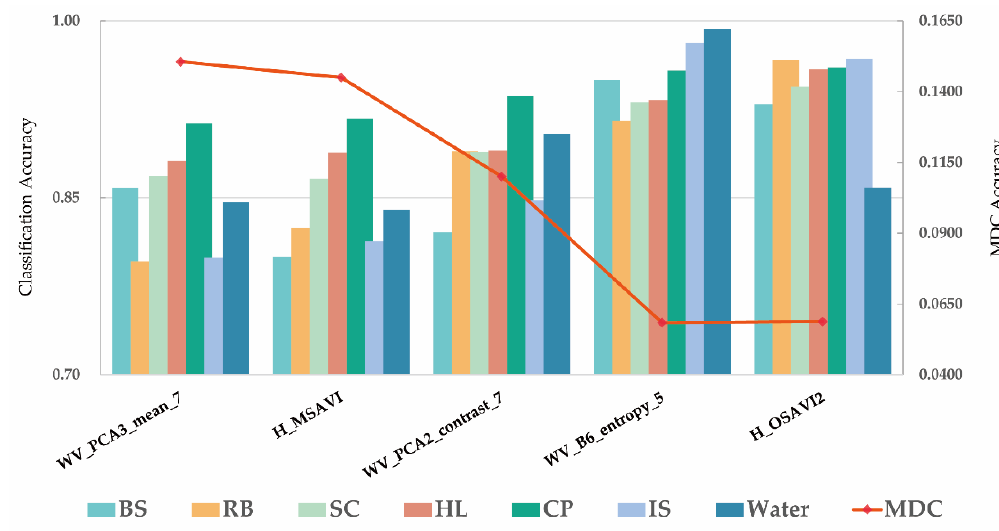
Figure 5. Comparison of fine classification accuracy of the seven important features.